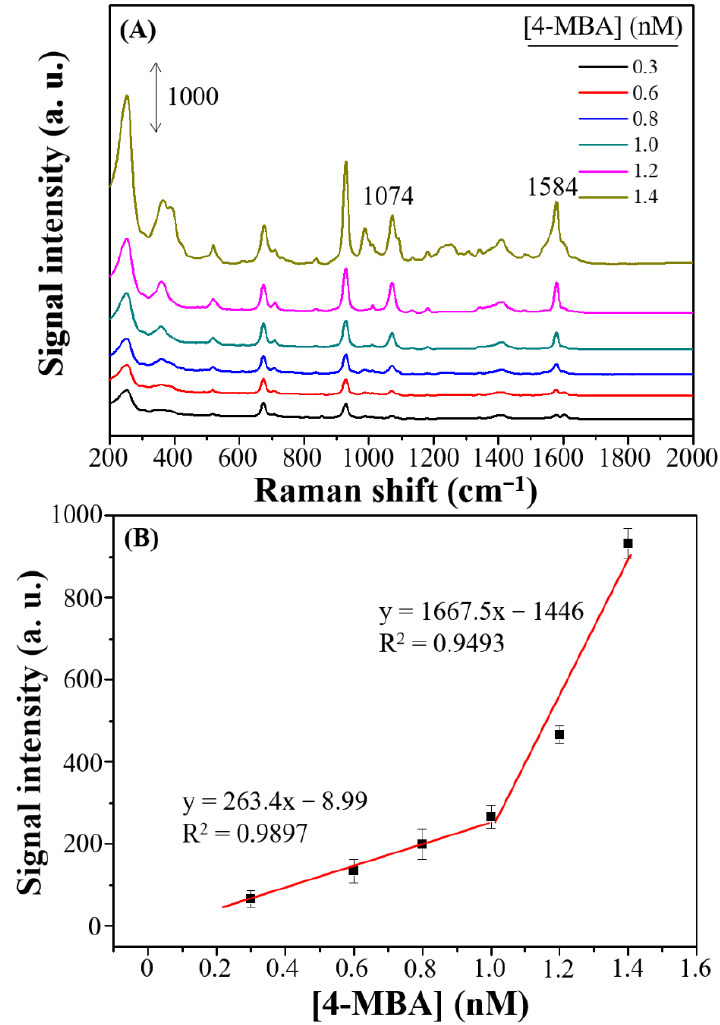
Figure 9. ( A ) SERS spectra at various 4-MBA concentrations on dendritic forest-like Ag nanostruc- tures. ( B ) Linear responses of the Raman intensity plotted with respect to the concentration of 4-MBA. The error bars represent the standard deviations for triplicate experiments using three batches of Ag substrates.